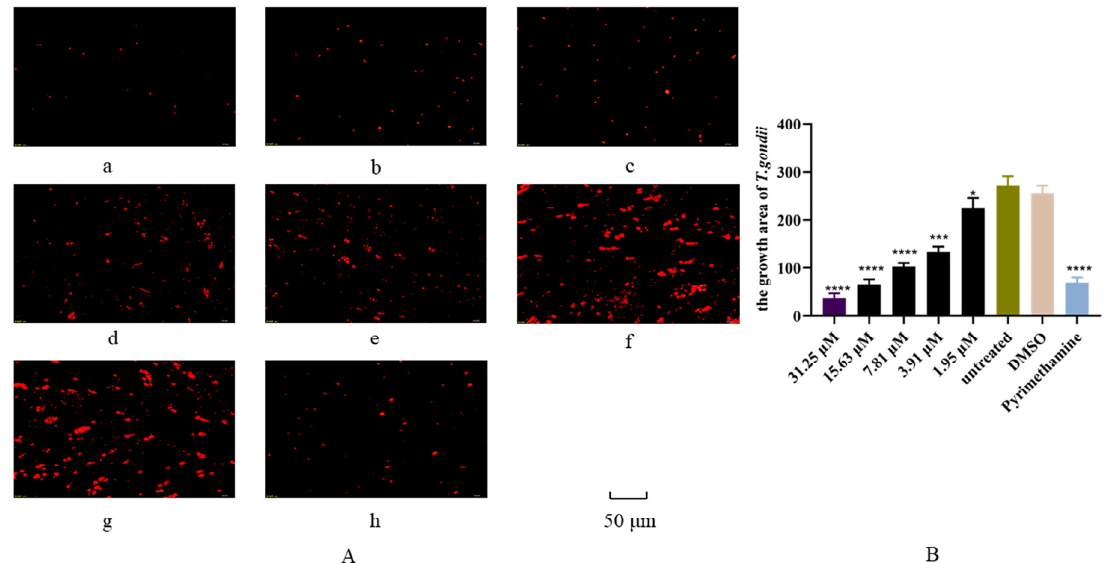
Figure 4. Anti- T. gondii activity of artemether was evaluated by RH-RFP growth assay. The HFF cells were infected by RH-RFP and treated with different concentrations of artemether and pyrimethamine for 24 h, respectively. The growth rate was calculated by measuring the fluorescence intensity. ( A ): Fluorescence area indicates the growth rate of T. gondii . ( a – e ) HFF cells were infected with RH-RFP and treated with different concentrations of artemether. ( a ) 31.25 µ M, ( b ) 15.63 µ M, ( c ) 7.81 µ M, ( d ) 3.91 µ M, ( e ) 1.95 µ M, ( f ) untreated, ( g ) DMSO and ( h ) pyrimethamine as positive control. ( B ): Statistical analysis of the growth rates in different treated groups. Each bar presented as the mean ± standard error, three independent experiments were performed, and 3 technical replicates were included in each experiment. All images were observed under 200 × magnification and scale bars equal to 50 µ m. * p < 0.05, *** p < 0.001, **** p < 0.0001. RH-RFP was cultured in monolayers of HFF cells and treated with different concen- trations of artemether for 24 h. The growth rate of RH-RFP tachyzoites was statistically counted using Image-Pro Express and plotted by Graphpad Prism 8.0, and the base of log concentrations were used to analyze the IC 50 . The data are presented as the mean ± SD. Three independent experiments were performed, and three technical replicates were in- cluded in each